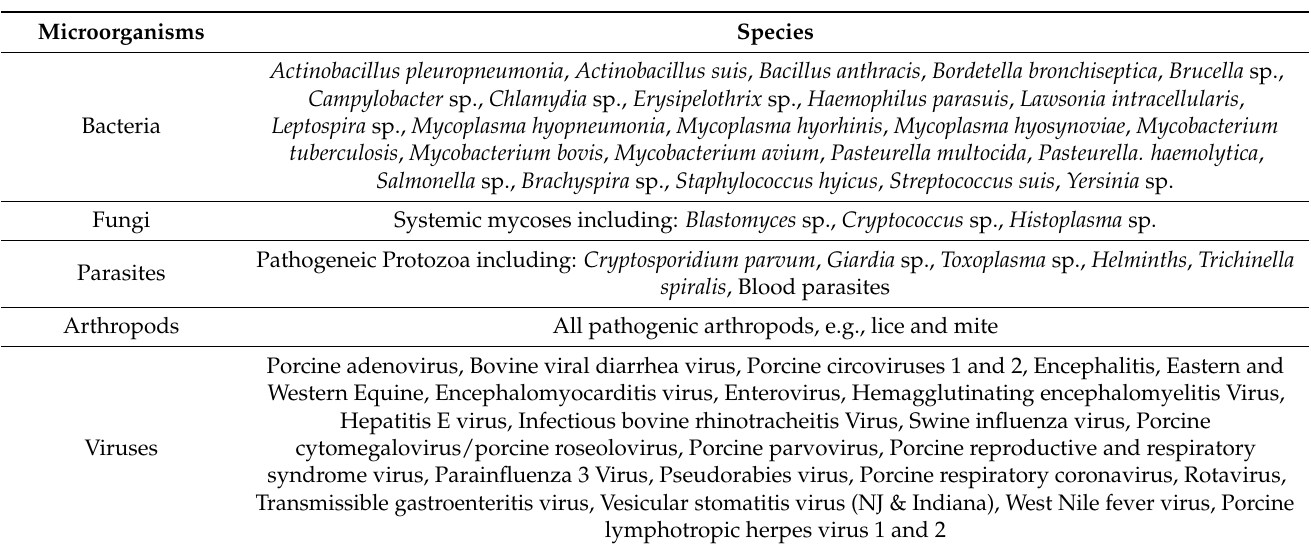
Table 4. Microorganisms excluded from a colony of designated pathogen free pigs